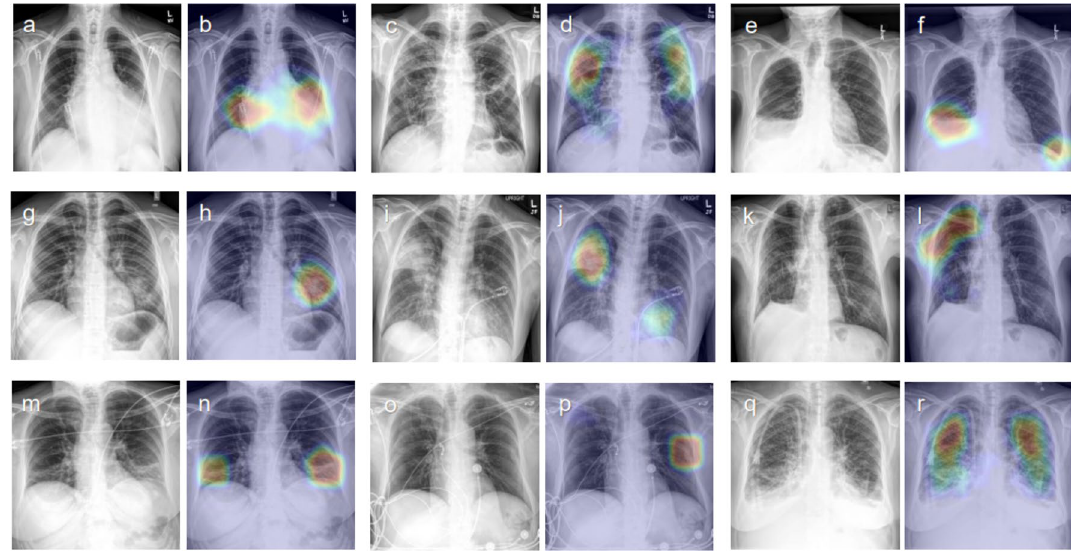
Figure 1. Representative class activation maps (CAMs) with correct lesion localization. ( a,b ) Cardiomegaly (PA), ( c,d ) Other interstitial opacity (PA), ( e,f ) Pleural effusion (PA), ( g,h ) Pneumonia (PA), ( i,j ) Pneumonia